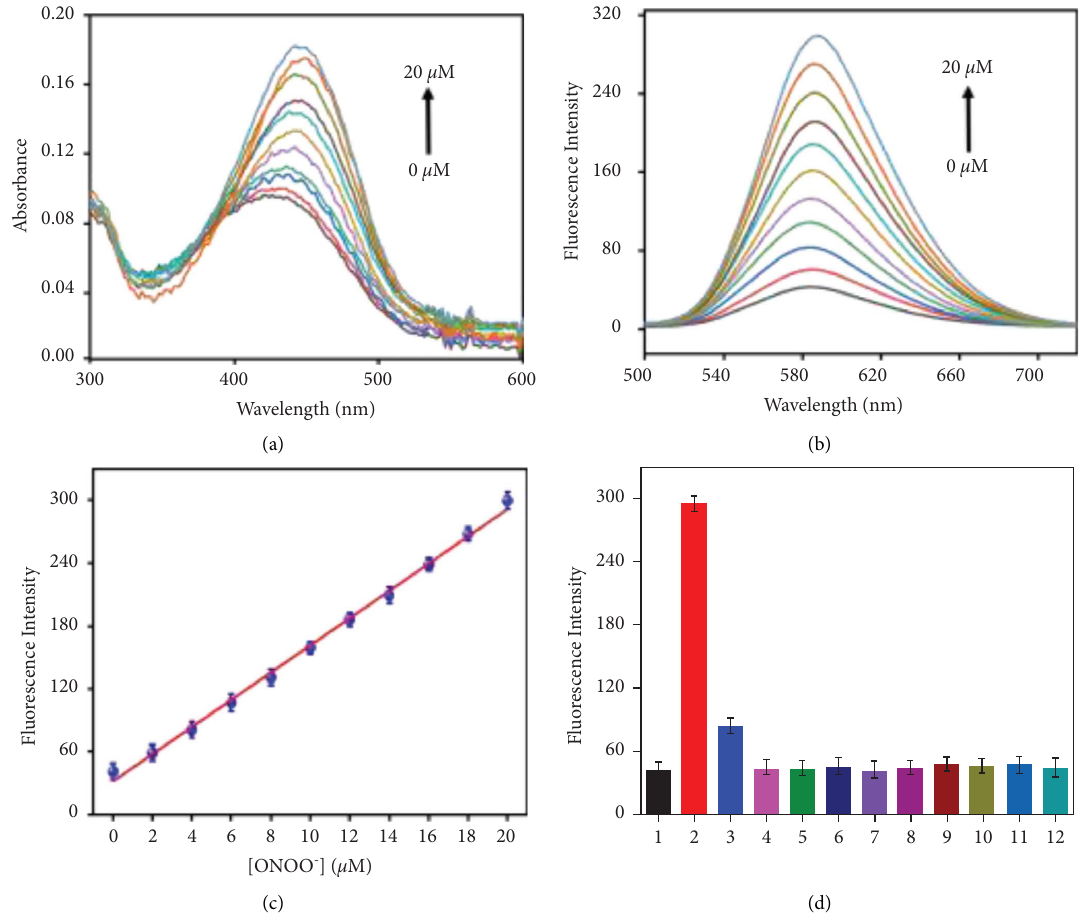
Figure 1: Spectral characteristics of HND-ONOO. (a) UV-Vis absorption and (b) the fuorescence spectrum of probe toward ONOO − (0–20 µ M). (c) Te linear relationship between the fuorescence intensity and ONOO − . (d) Te response of HND-ONOO to various active substance: 1, blank; 2, ONOO − (20 µ M); 3, H 2 O 2 (100 µ M); 4, HClO (100 µ M); 5, O 2 • - (100 µ M); 6, • OH (100 µ M); 7, t BuOO • (100 µ M); 8, NO (100 µ M); 9, HNO (100 µ M); 10, GSH (10mM); 11, Hcy (10 mM); 12, Cys